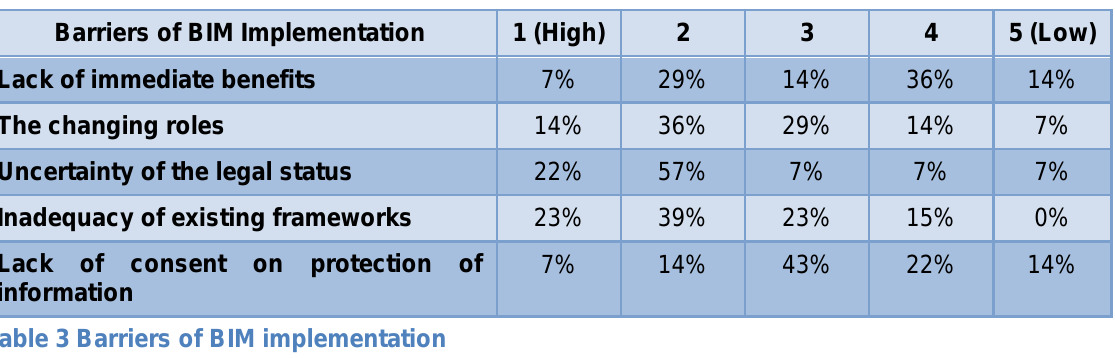
Table 3 Barriers of BIM